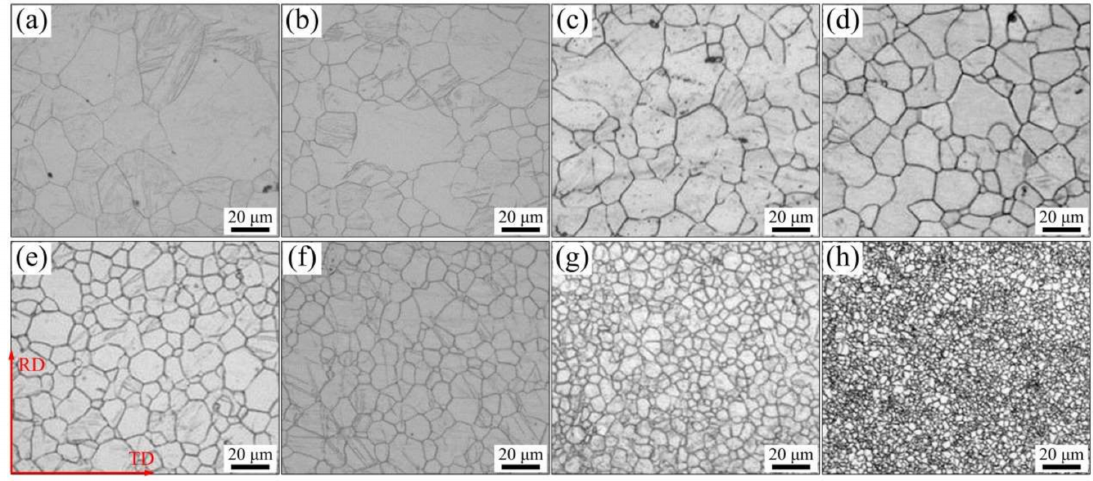
Figure 2. Microstructure characteristics of AZ31 magnesium alloy sheets during multi-pass lowered- temperature rolling: ( a ) Pass 1; ( b ) Pass 2; ( c ) Pass 3; ( d ) Pass 4; ( e ) Pass 5; ( f ) Pass 6; ( g ) Pass 7; ( h ) Pass 8. (RD: rolling direction, TD: transverse